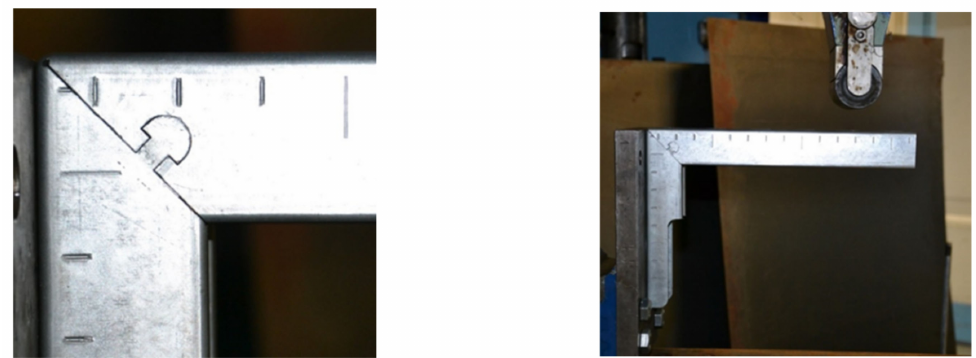
Figure 20. Correctly made console with a semicircular lock in close-up; console before loading on the experimental stand (40 mm × 40 mm